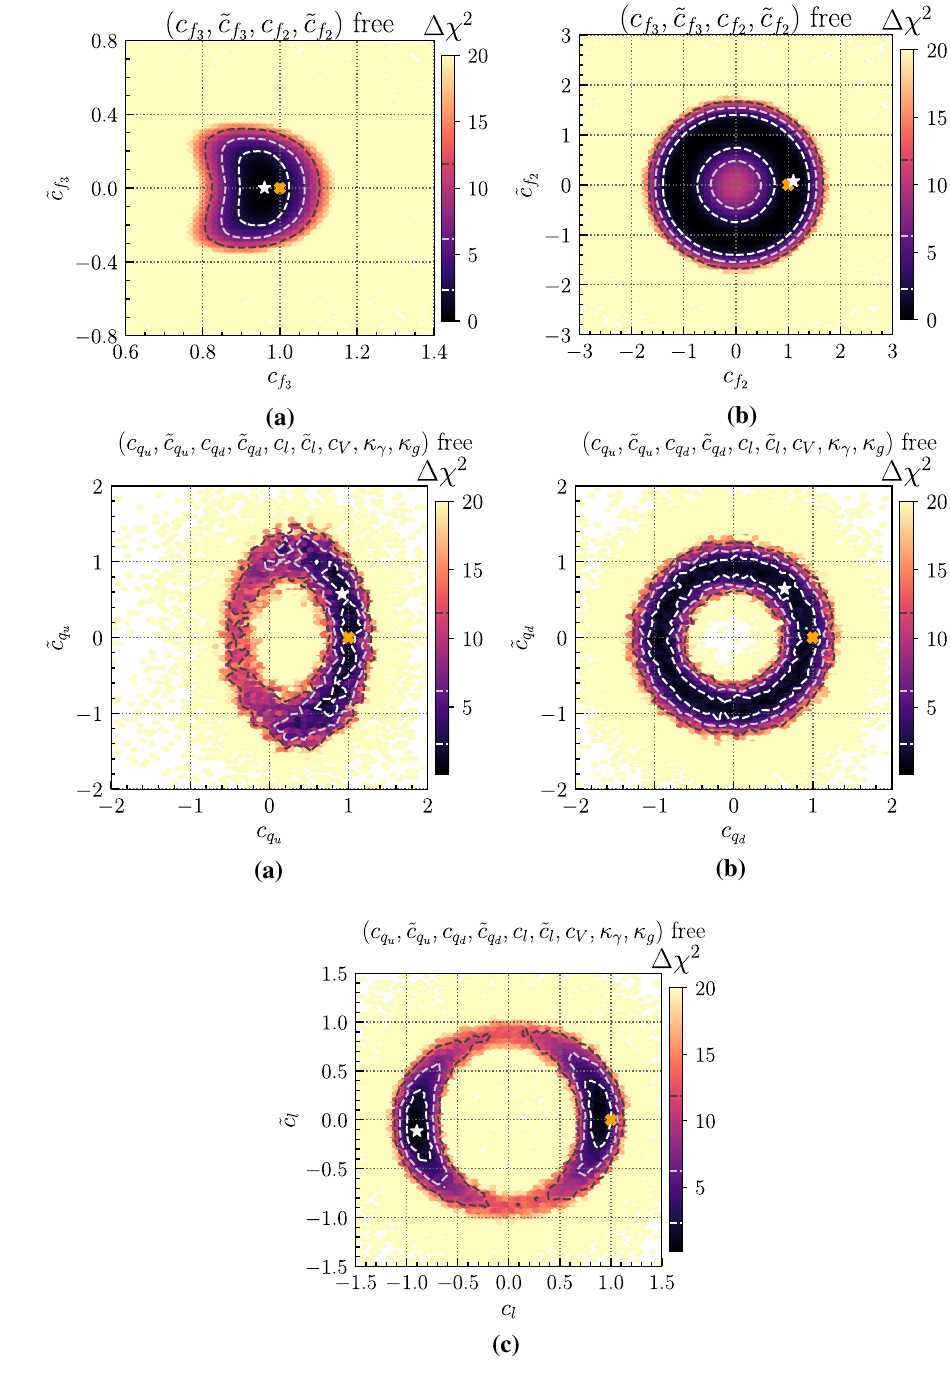
Fig. 17 Results of fits to the LHC measurements in the ( a ) ( c f , ˜ c f ) and ( b ) ( c f , ˜ c f ) 3 3 2 2 parameter plane. For each plot the indicated coupling modifiers are free-floating while all the other parameters are set to their SM values. The legend corresponds to the one in Fig. 2